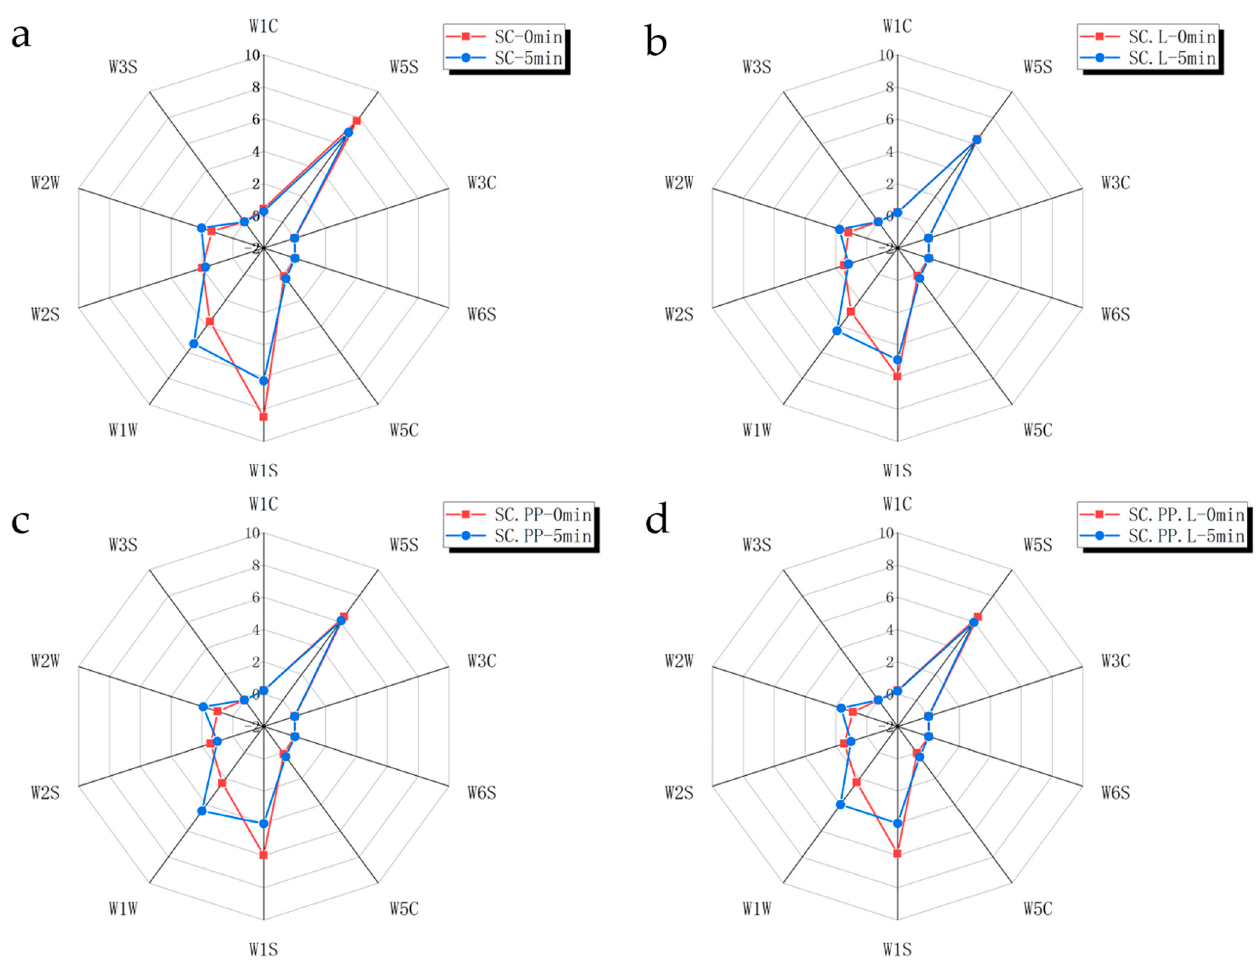
Figure 1. E-nose radar chart of different groups of jujube liquor. ( a ) Comparison chart of SC; ( b ) Comparison chart of SC.L; ( c ) Comparison chart of SC.PP; ( d ) Comparison chart of SC.PP.L; ( S. cerevisiae -‘SC’, S. cerevisiae and Lactobacillus -‘SC.L’, S. cerevisiae , and P. pastoris -‘SC.PP’, S. cerevisiae , P. pastoris , and Lactobacillus -‘SC.PP. L’; 0min-test immediately after putting the sample into the test bottle, 5min-test after standing the sample at room temperature for 5 min).